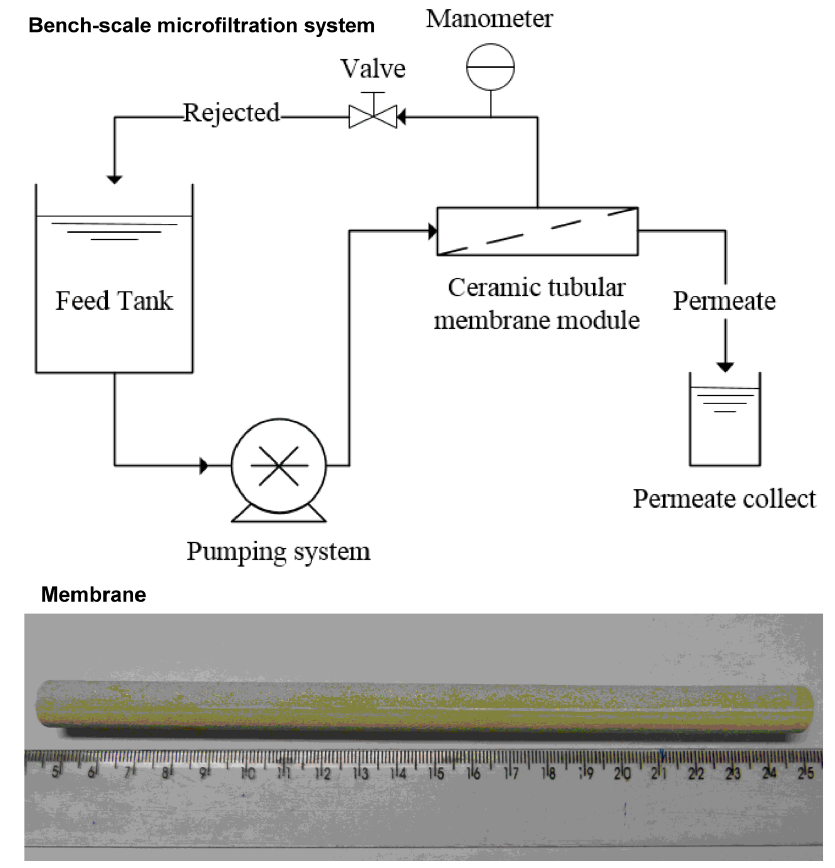
Figure 1. Microfiltration system and mullite ceramic membrane.